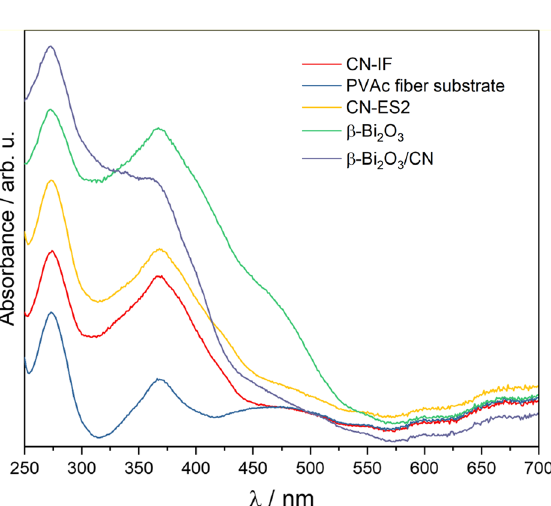
O /CN-ES and β-Bi 2 3